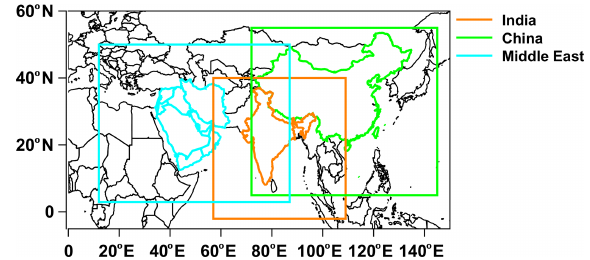
Figure 1. The model domains for India, China, and the Middle East used in the present study. The land regions for the emissions are shown in color.